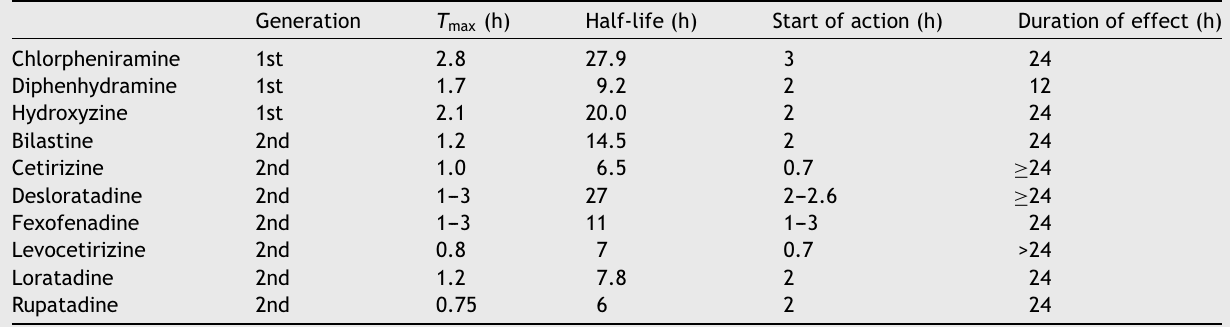
Pharmacokinetics and pharmacodynamics of some antihistamines in adults. 11